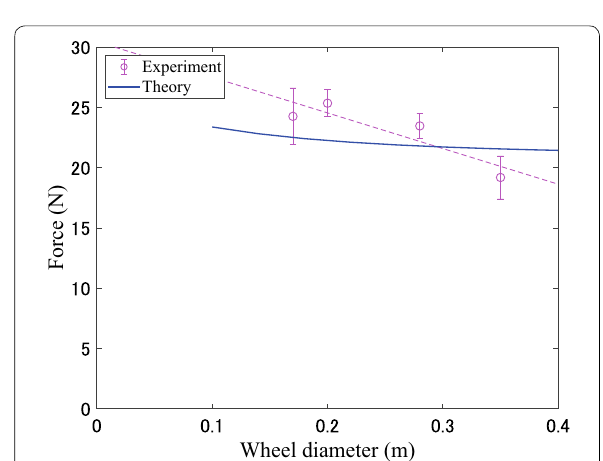
SD resistance force of steady-state sinkage at Fig. 17 Mean ± different wheel diameter. Width 0.04 m; mass 2.5